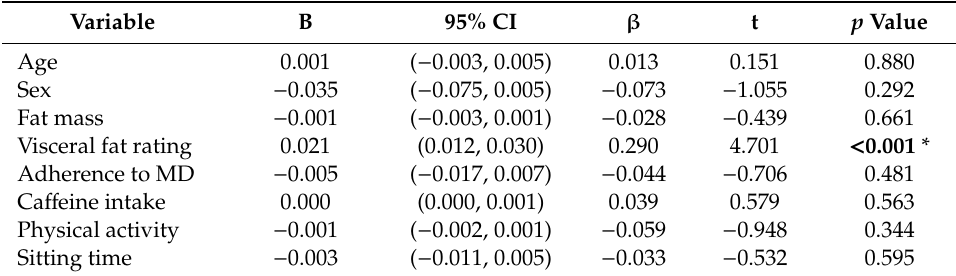
Table 9. Regression analysis for